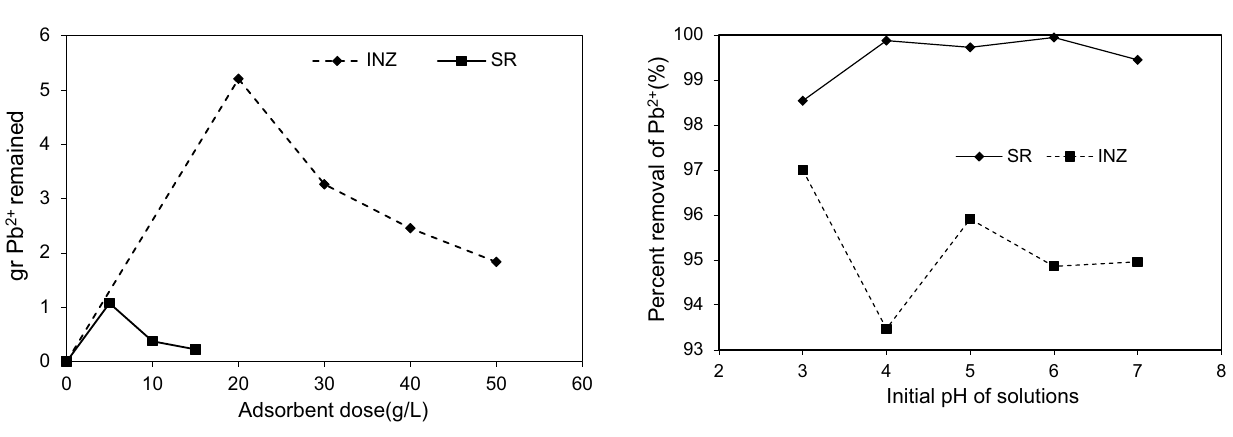
Fig. 5 Influence of adsorbent dose on Pb 2+ removal (pH = 4.5, initial concentration = 50 mg/L, contact time = 120 min)